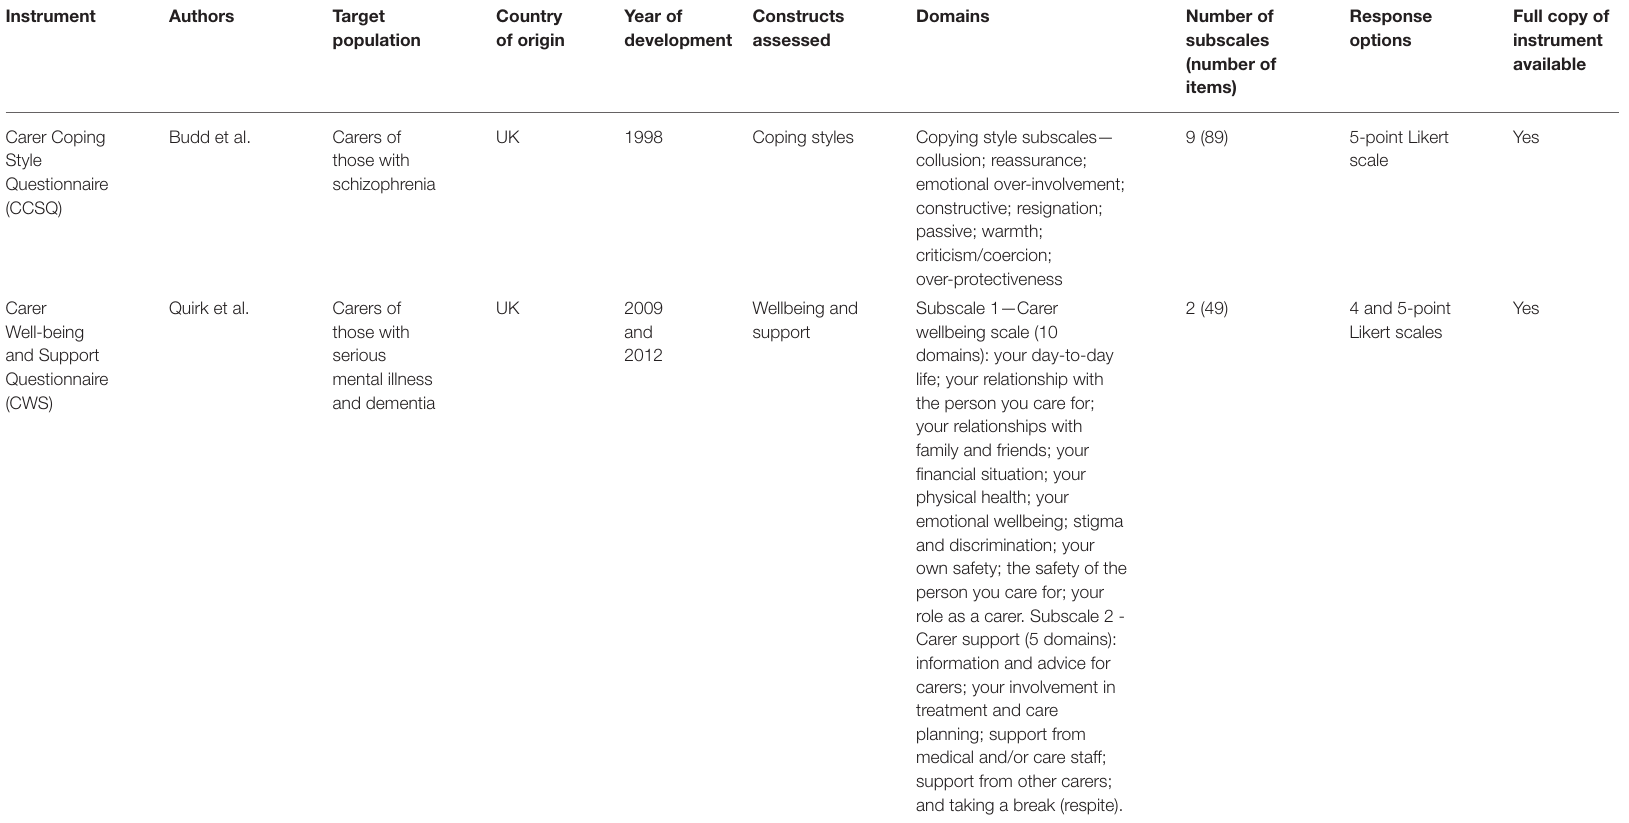
TABLE 1 | Characteristics of included